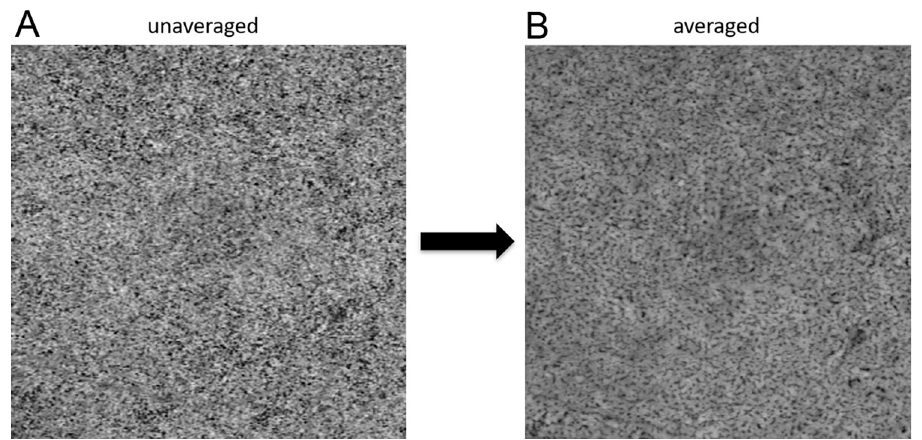
Fig 2. Averaged en face OCTA images of the choriocapillaris. A. A single en face OCTA image of the choriocapillaris before averaging. A granular appearance is observed. B. An en face OCTA image of the choriocapillaris after averaging. A continuous capillary meshwork is observed.